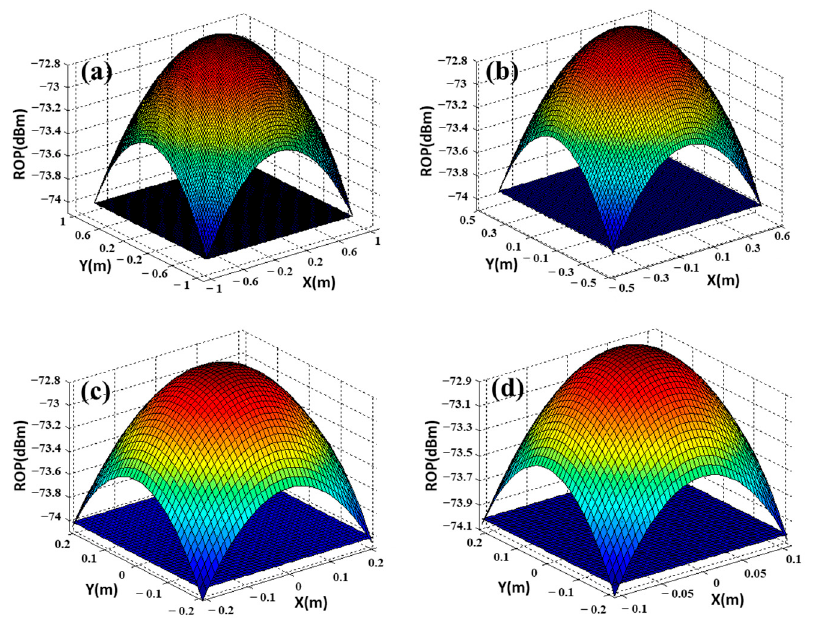
Figure 9. Optical power distribution at the receiving plane within the receiver sensitivity of − 74 dBm: ( a ) c = 0.056 m − 1 , z = 83.5 m, D r = 1.28 m; ( b ) c = 0.151 m − 1 , z = 40.5 m, D r = 0.62 m; (c ) c = 0.398 m − 1 , z = 19.2 m, D r = 0.29 m; ( d ) c = 0.92 m − 1 , z = 10 m,. D r = 0.15 m.